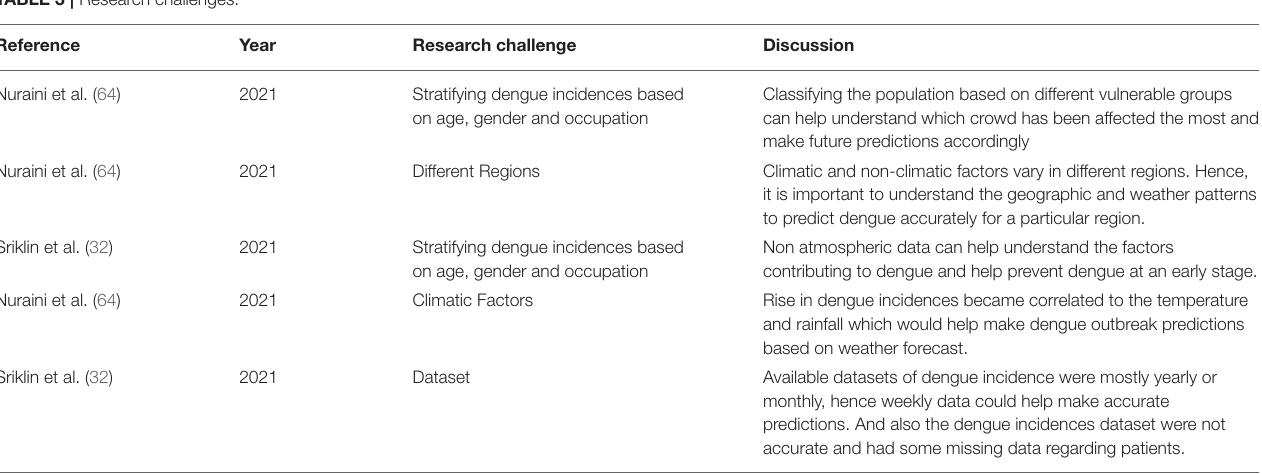
FIGURE 9 | A logical mapping of research challenges and possible solutions. TABLE 3 | Research